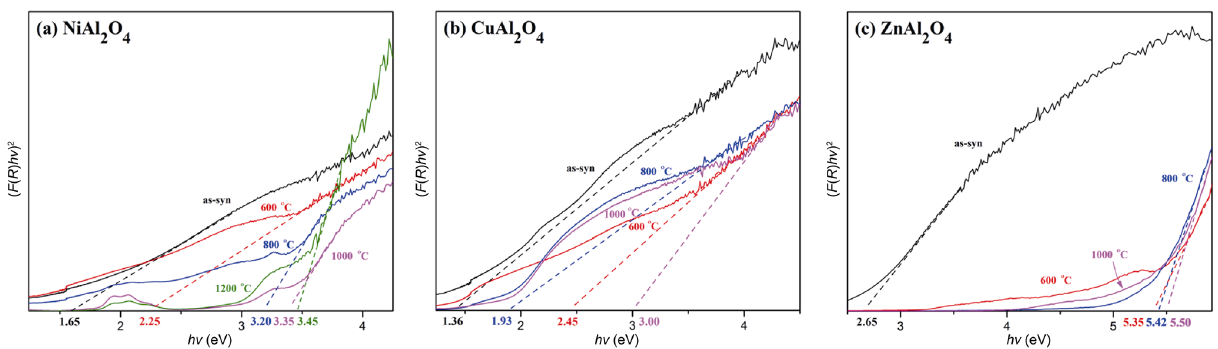
Fig. 7 Plot of ( F ( R ) hν ) 2 vs. hν for (a) NiAl 2 O 4 , (b) CuAl 2 O 4 , and (c) ZnAl 2 O 4 powders calcined at different temperatures.